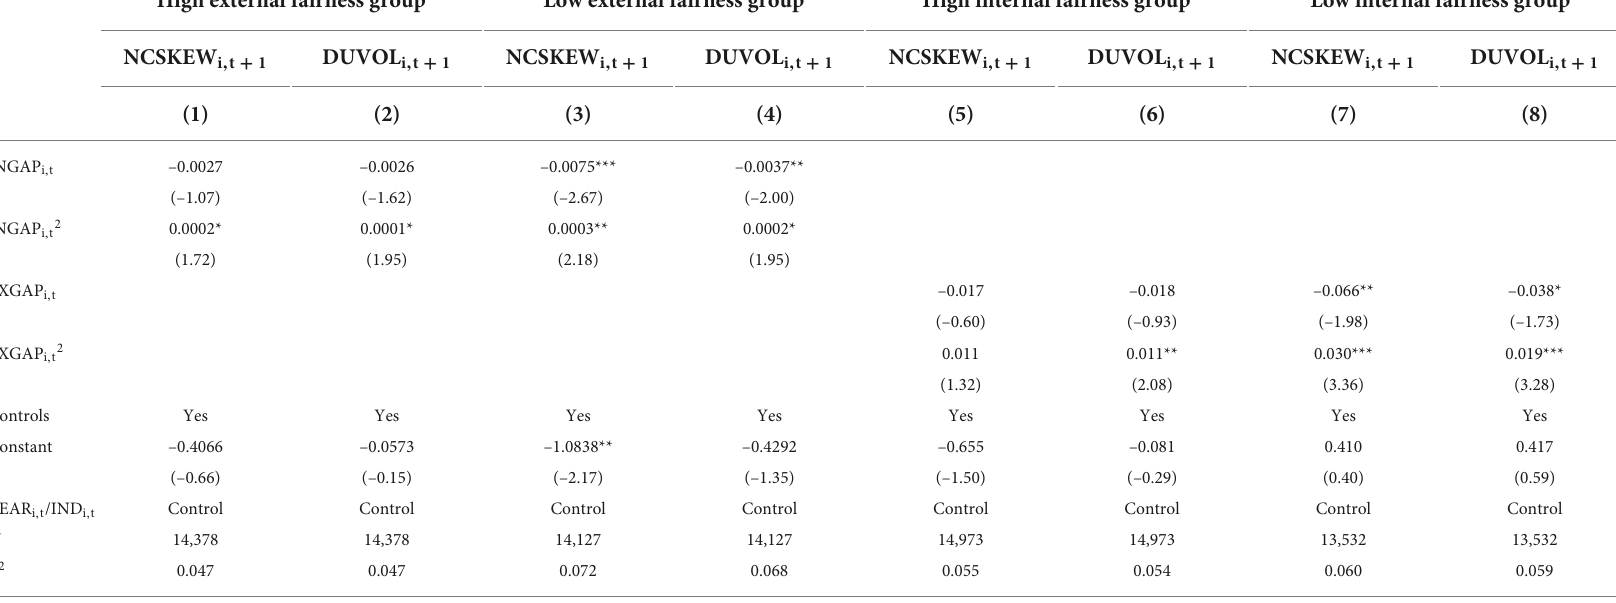
TABLE 7 The pay gap and crash risk: Effects of compensation